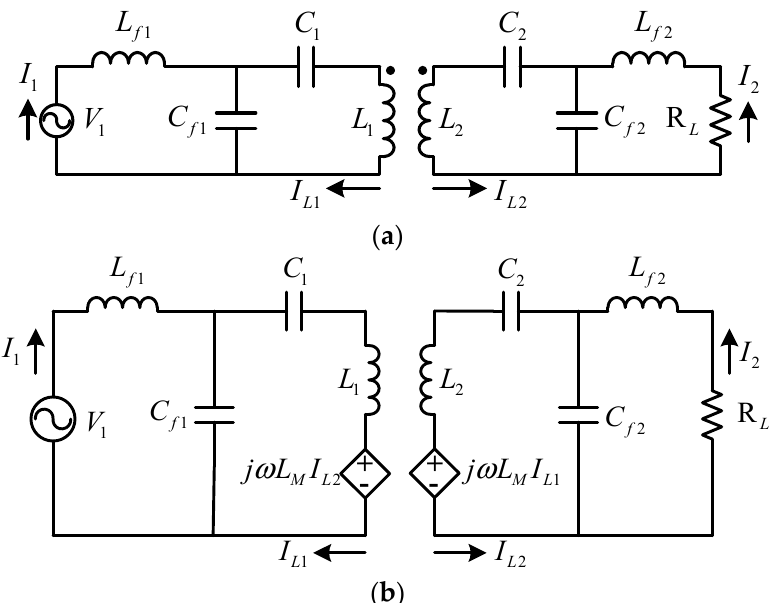
Figure 1. Double-sided LCC compensation topology. ( a ) Double-sided LCC resonant circuit. ( b ) Equivalent circuit.